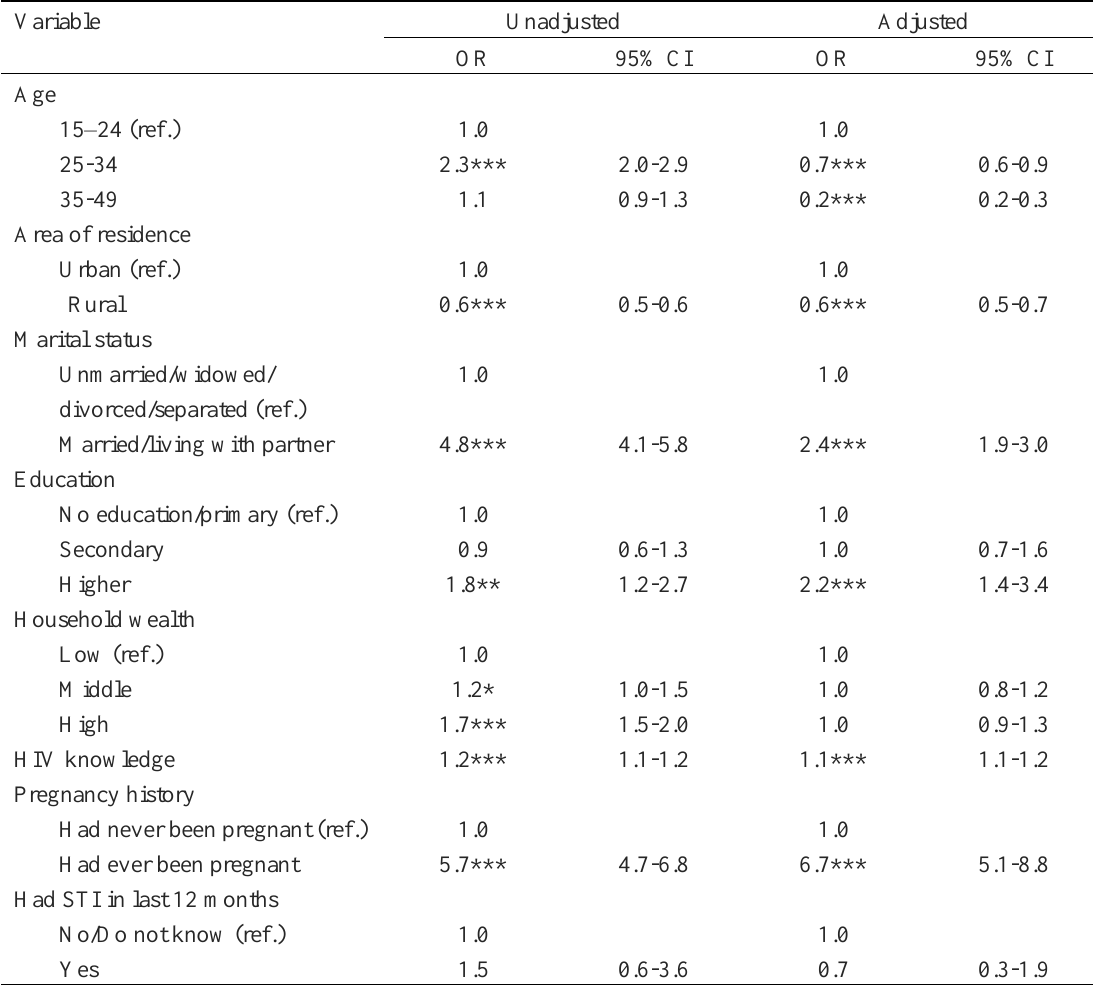
Table 2 . Unadjusted and Adjusted Estimates from Logistic Regression Models Predicting HIV Testing among Women (n = 5,867) knowledge score at 4.9 (SD = 2.3), indicating moderate levels of overall HIV knowledge. Overall, 1,501 (26%) of respondents reported HIV testing in the past. Table 2 presents unadjusted and adjusted estimates from logistic regression